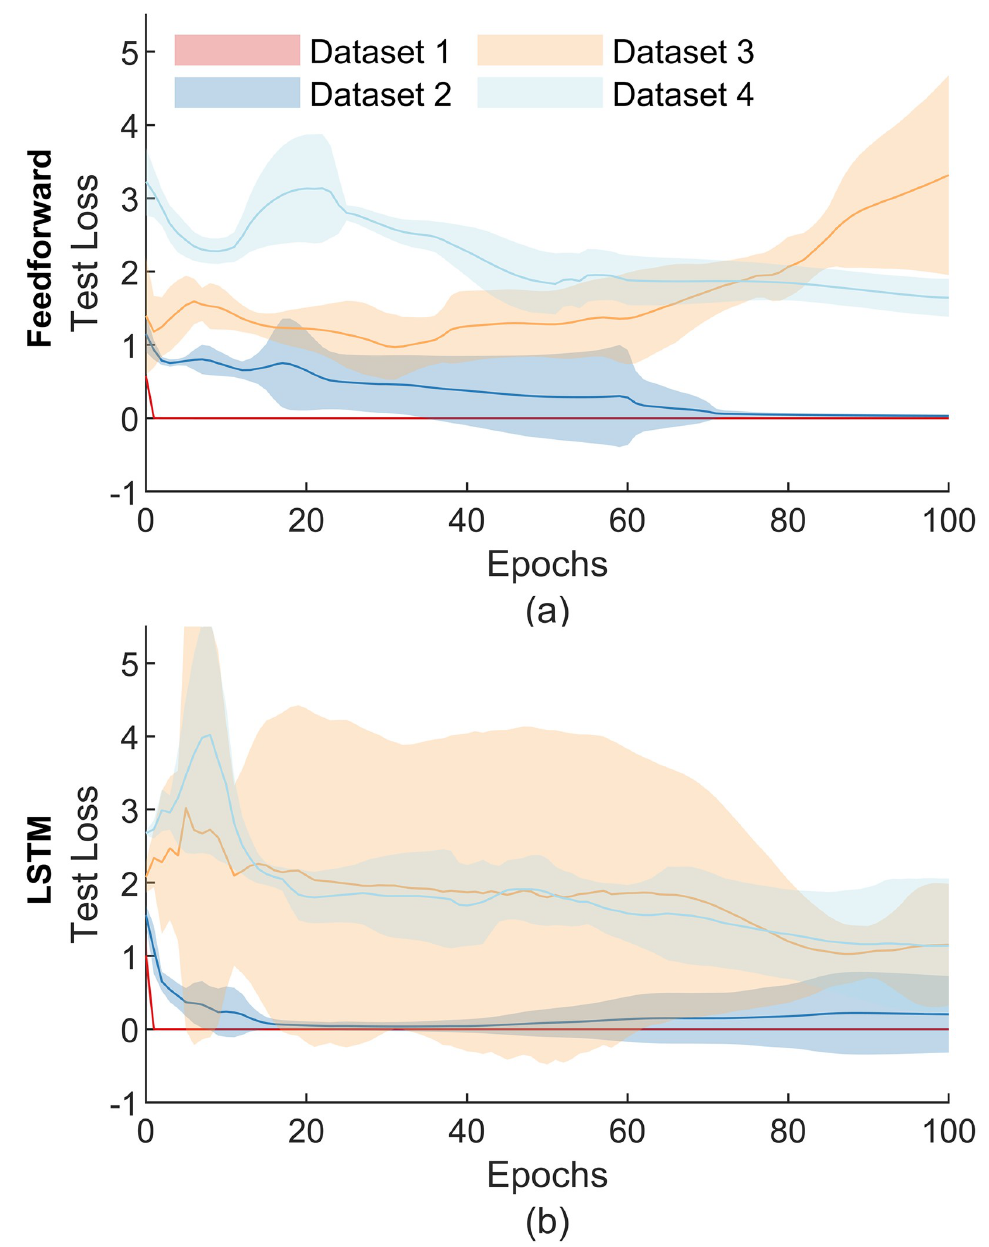
Fig 4. Test losses of each artificial neural network. Test losses across epochs through 5-fold cross-validation for feedforward (a) and LSTM (b) neural network models. Shaded regions represent 95% confidence intervals. Losses for datasets tended to decrease across epochs as model weights converged. Datasets which altered more muscles tended to have larger confidence intervals.